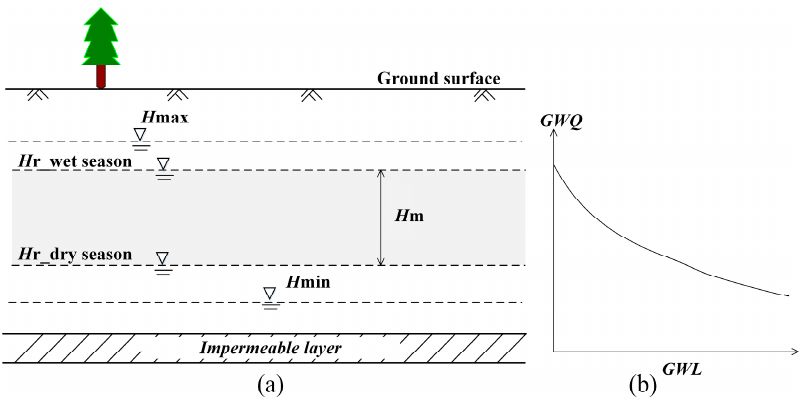
Figure 1. Schematic figures of water level control ( a ) and the relation between groundwater quality (GWQ) and groundwater level (GWL) ( b ).